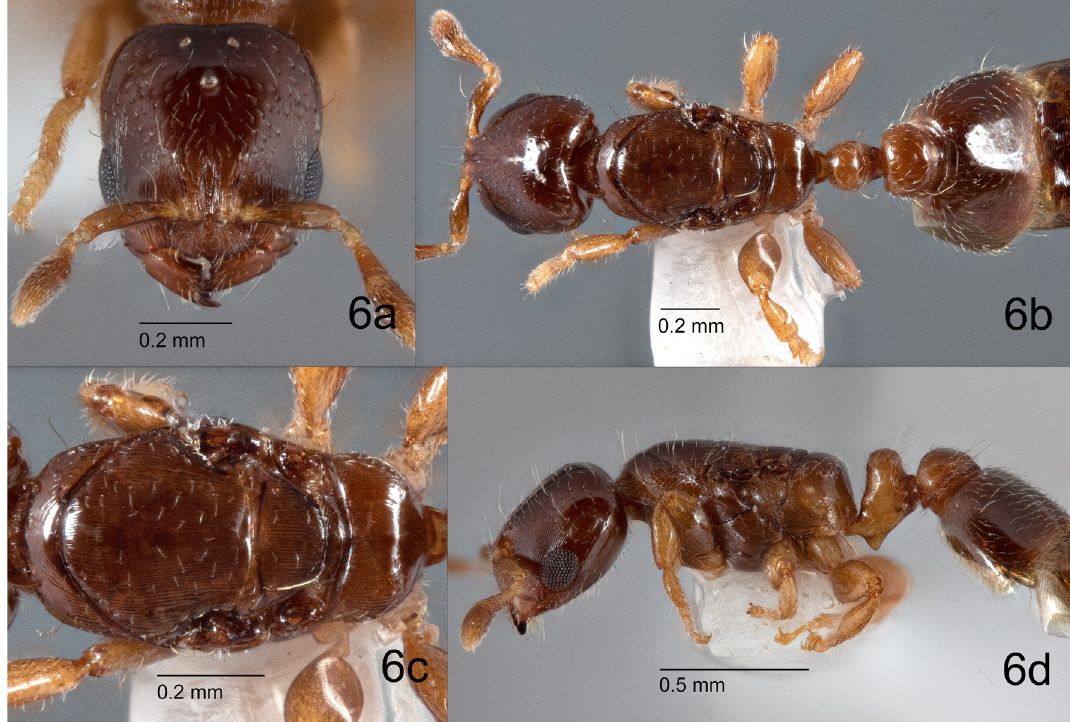
Fig. 6. Rhopalomastix javana Wheeler, 1929, non-type, queen, Northeast Thailand (THNHM-I-21751). a . Head in full-face view. b . Body in dorsal view. c . Close-up of mesosoma in dorsal view. d . Body in lateral